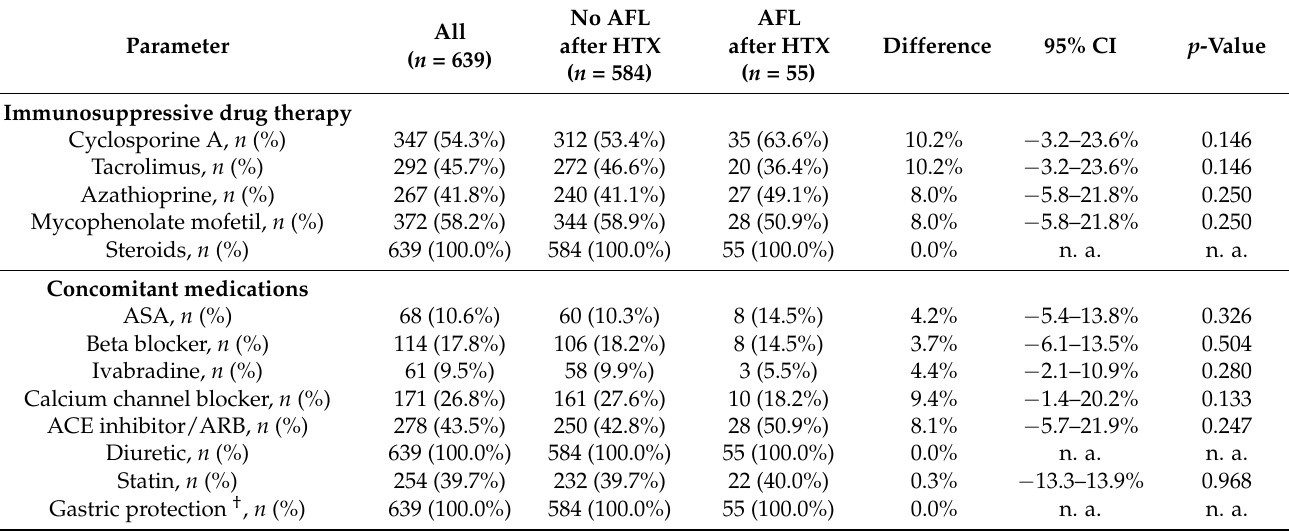
Table 3. Medications-stratified by late-onset AFL after HTX.